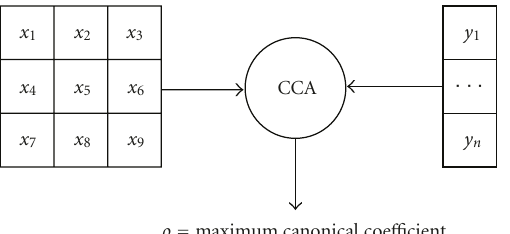
Figure 2: CCA applied to a 3 × 3 region of voxels in the di ff raction data of Figure 1 and a set of n spectral basis functions